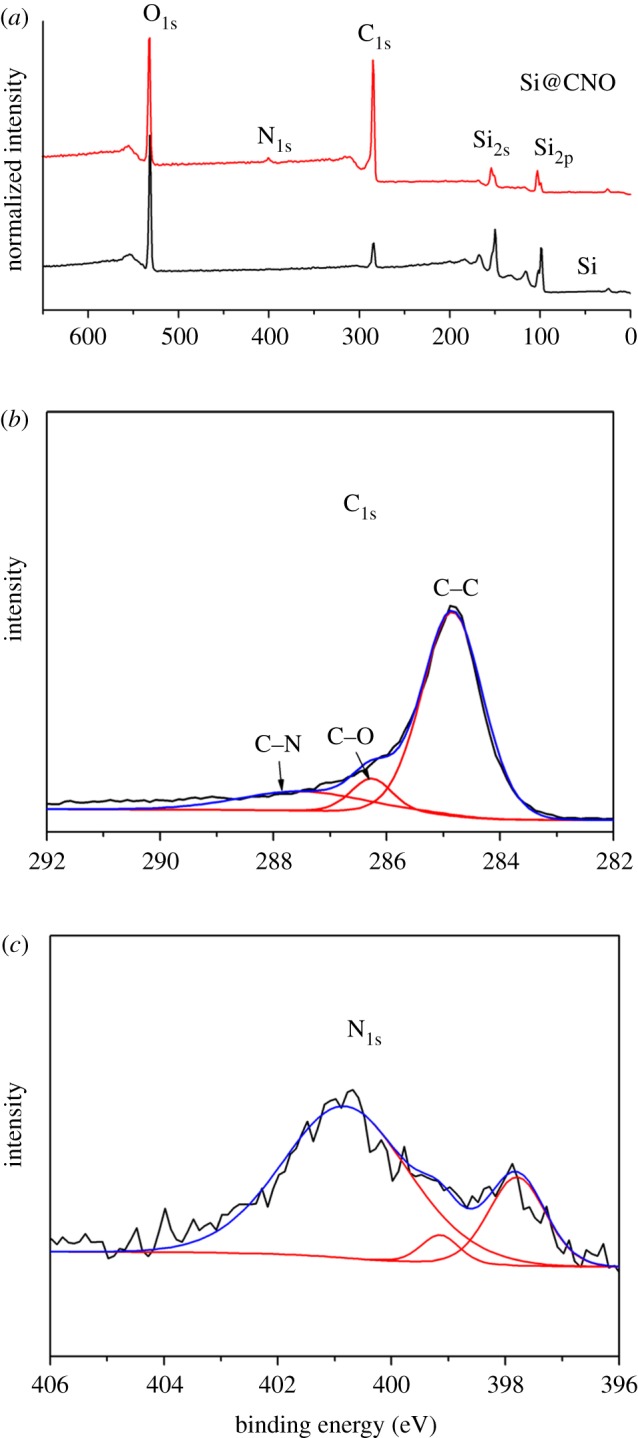
(a) XPS patterns of Si and Si@CNO, and XPS spectra of (b) C1s and (c) N1s for Si@CNO.